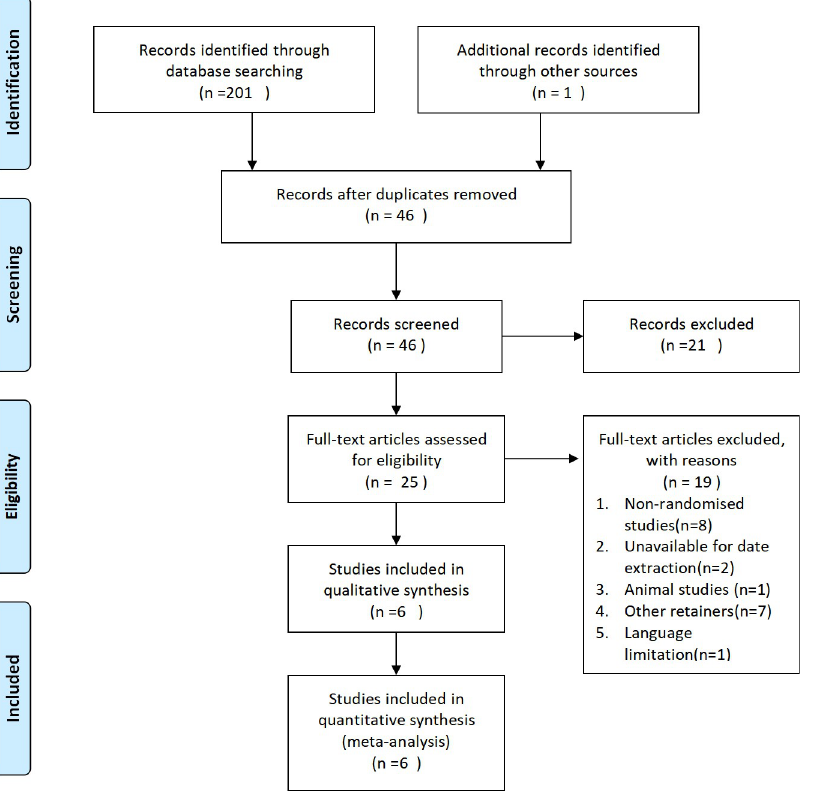
Fig 1. PRISMA 2009 flow